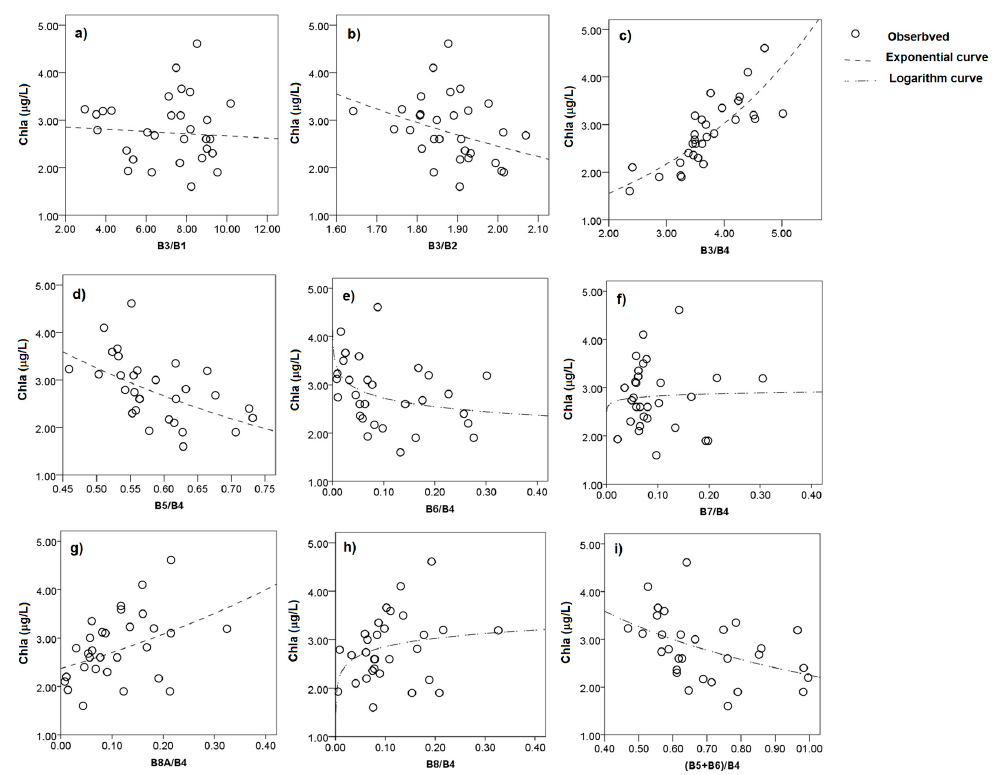
Figure 3. Cross-relationships of in situ Chla and in situ reflectances corresponding to the S2A band ratios as commonly used to estimate Chla in the reviewed literature (green-to-blue band ratios ( a , b ); green-to-red band ratio ( c ); NIR-to-red band ratios ( d , e , f , g , h , i )). Abbreviations of the S2A band 1 to band 8a corresponded to B1 to B8a. The highest correlation and the smallest error of S2A B3/B4 with in situ Chla confirmed the appropriateness of using this two-band ratio for estimating Chla in Lake Ba Be water ( c ).